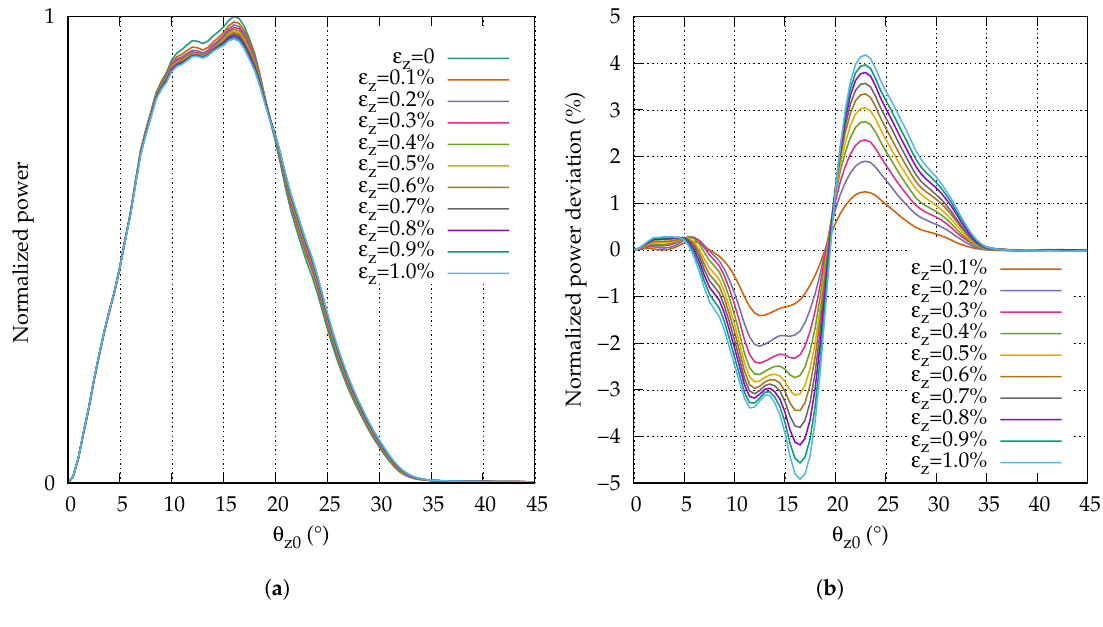
Figure 8. Strain-dependent far field ( a ) and far field changes ( b